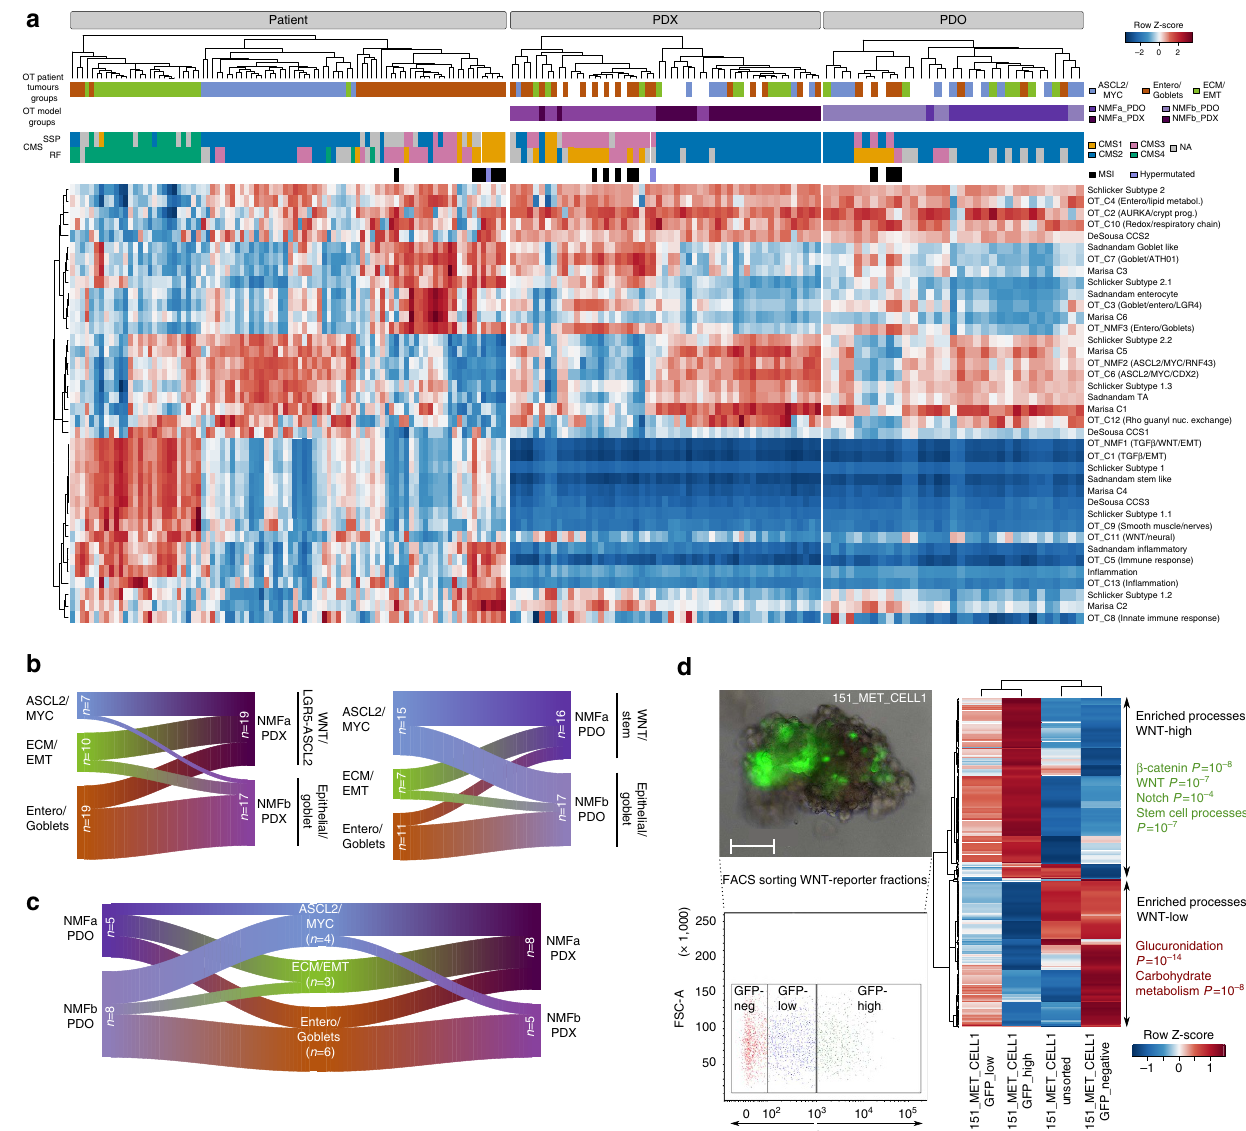
Figure 4 | Expression profiling of the OT patient (tumour purity Z 40%) and model cohorts. ( a ) Unsupervised hierarchical clustering of the mean patterns of 38 CRC-related signatures in 90 patients, 53 PDX and 33 PDO models. Information on molecular groups is indicated as follows from top to bottom under the dendrogram. Colour labels of the three OT patient tumour groups, NMF classes for the models, and CMS groups (RF: upper row, SPP: bottom row) are indicated in the caption on the right side. MSI- and hypermutated samples are marked with black and blue boxes, respectively. ( b ) Sankey plots showing the correspondence between the molecular groups in the patient tumours (ECM/EMT, ASCL2/MYC, Entero/Goblets) and the two NMF groups in PDX and PDO models. ( c ) Sankey plots showing the correspondence between the NMF molecular groups between sibling pairs of PDX and PDO models. ( d ) Analysis of WNT-signalling reporter assays on 151_MET PDO cultures. Left: cell cultures showing the GFP green fluorescent signal revealing WNT signalling and FACS-sorting of the corresponding GFP-high, -low and -negative cell fractions. Scale bar is 100 m m. Right: Heatmap representing differentially expressed genes ( n ¼ 404) between the GFP-low, GFP-high, GFP-negative cell fractions and unsorted cells. Genes were filtered by fold change (FC) and difference of RPKM (DR, |DR| Z 1, |log 2 (FC)| Z 2). Key enriched processes and P -values in WNT-negative and -high fractions are indicated on the right side.